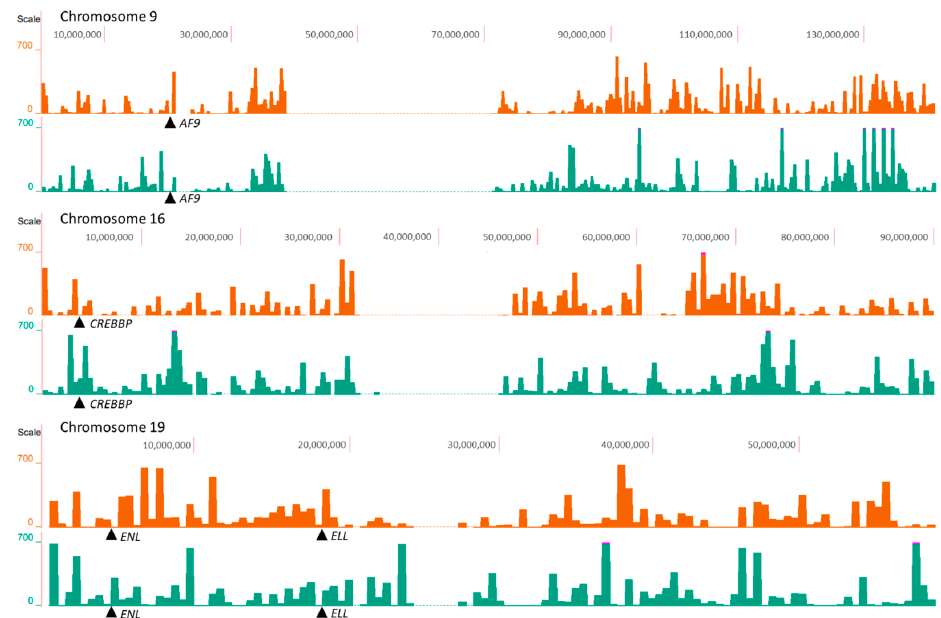
Figure 5. 4C-seq profiles of MLL from untreated cells (orange) and from cells treated with etoposide (green). The 4C-seq profiles of MLL on chromosome 11 show cis -contacts (first pair of rows), and the 4C-seq profiles of MLL on chromosomes 4, 9, and 19 show MLL trans- contacts with chromosomes that bear MLL translocation partners in TI-related AML (other pairs of rows). MLL translocation partner genes are indicated by arrows. Data resolution is 500 kb. 4C-seq data are collected in Table S3.